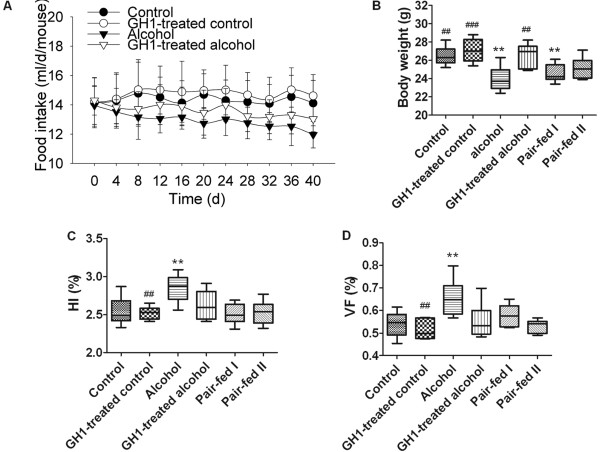
Food intake and body composition. (A) Daily food intake. (B) Body weight. (C) Hepatic index. (D) Visceral fat percentage. HI: hepatic index. VF%: visceral fat percentage. Error bars represent standard deviations. n = 6 mice per group. *P < 0.05 or **P < 0.01 vs. the control group; #P < 0.05, ##P < 0.01 or ###P < 0.001 vs. the alcohol group.